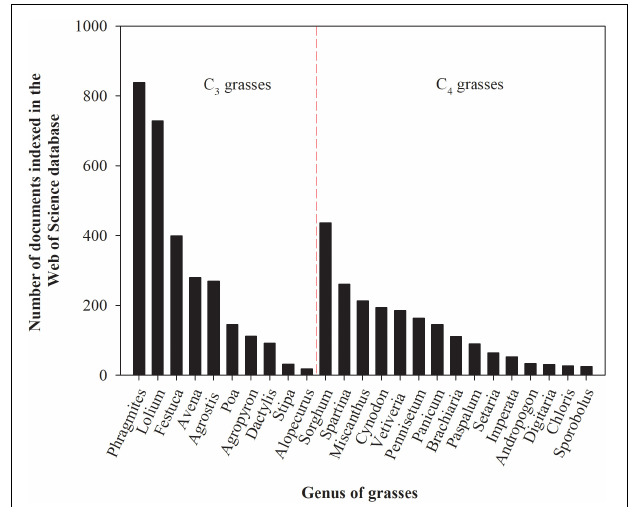
FIGURE 2 | The number of documents indexed in the Web of Science database assessing the tolerance and capacity of grasses genera (C 3 and C 4 ) to remediate environments polluted by potentially toxic trace elements. The numbers presented in the figure were obtained by using the name of the genus and the keyword heavy metals as search terms on February 22, 2021. These numbers are subjected to changes according to keywords used for search.